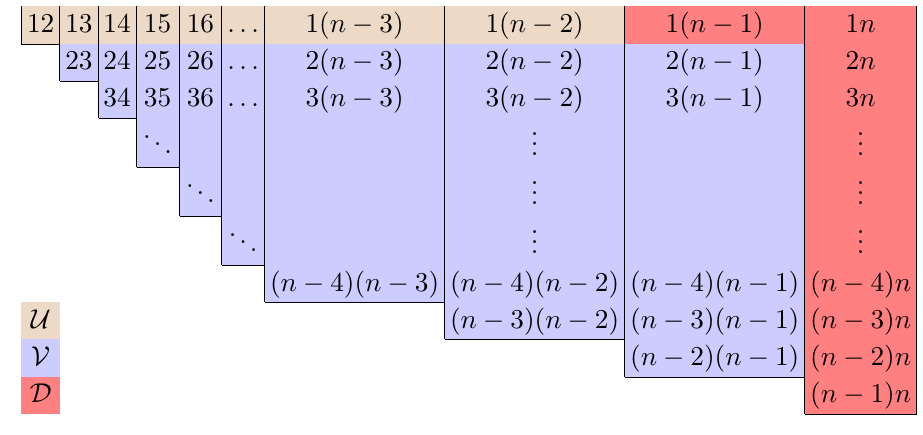
Figure 6. Color-coded matrix displaying the canonical choice of Mellin variable index subsets U comb , V comb and D comb